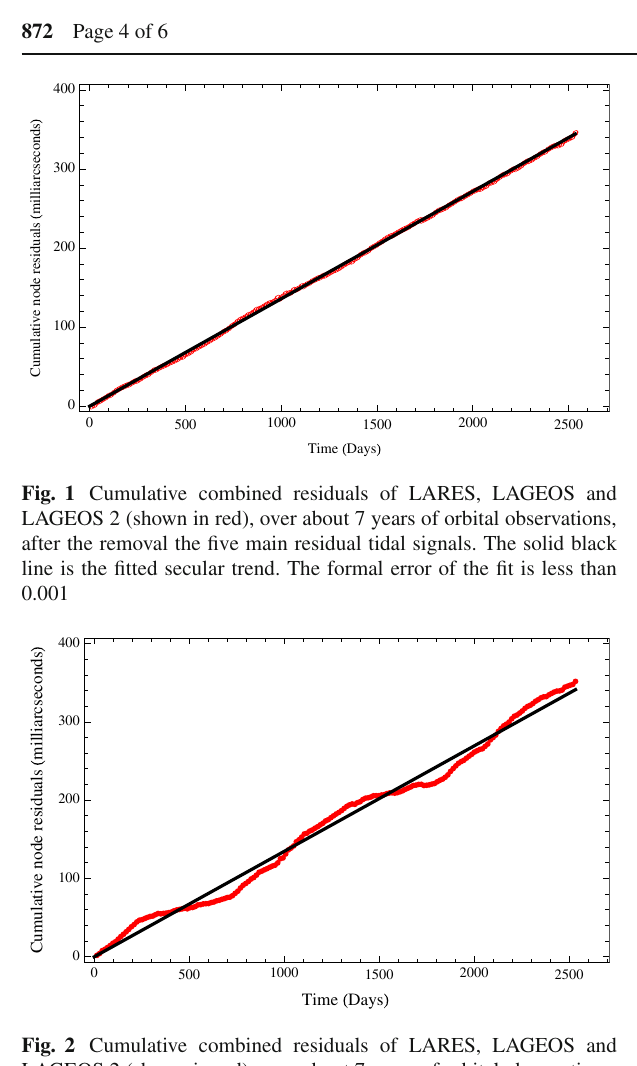
Fig. 2 Cumulative combined residuals of LARES, LAGEOS and LAGEOS 2 (shown in red), over about 7 years of orbital observations, fitted with a constant trend (shown with a solid black line)